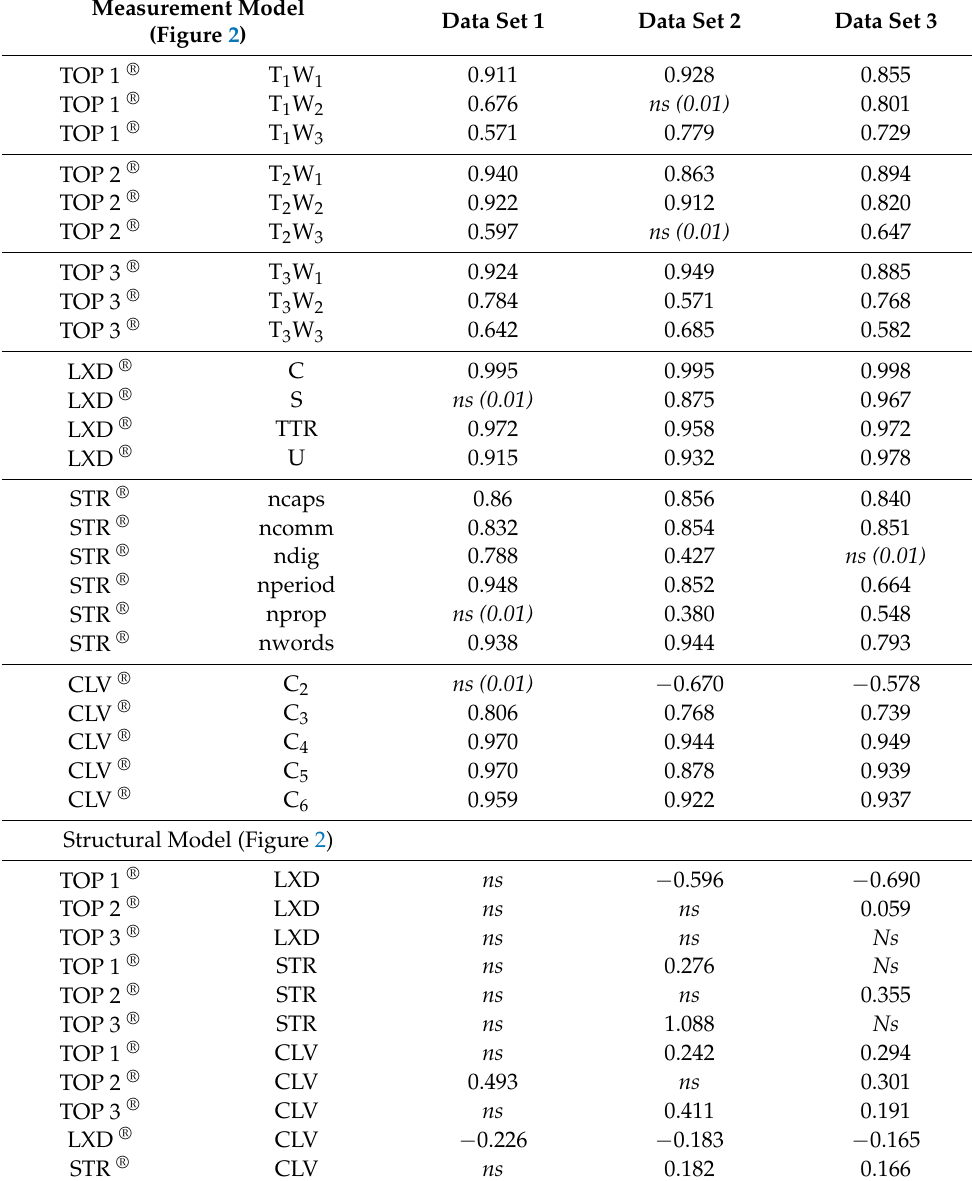
Table 4. Measurement model weights and structural model path coefficients estimates for the model in Figure 2 and for the data sets 1, 2 and 3. Using the bootstrap method with 500 pseudo- samples to obtain pseudo-confidence intervals, the symbol “ ns ” for some of the cells means that the corresponding values were considered non-significative at level